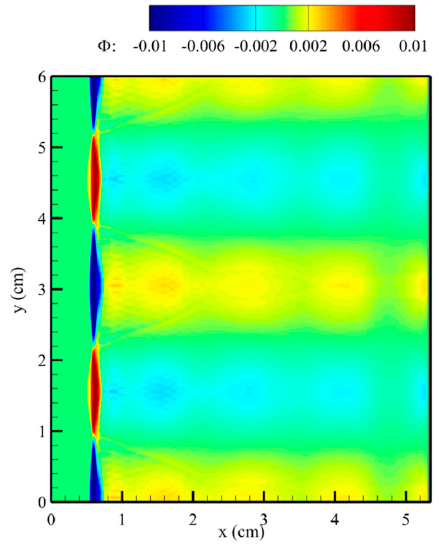
Figure 17. Primary mode of the weakly unstable detonation. Moderately unstable detonation case oscillates at a higher frequency and has more irregularity. At first, the POD and DMD spatial structures were compared as this process is not an oscillating phenomenon as observed with earlier shock-induced combustion case or regularly oscillating weakly unstable detonation case. Figure 18 shows the spatial structures of the coherent modes of POD and DMD, and they resemble the same with little differences in